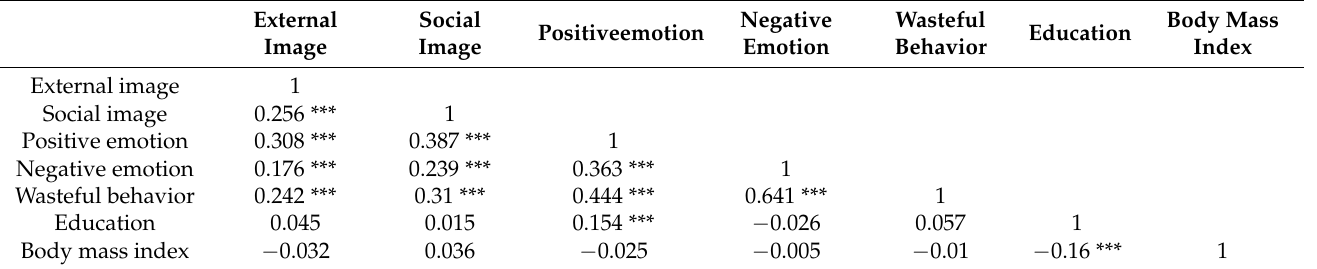
Table 3. Descriptive statistics and correlation